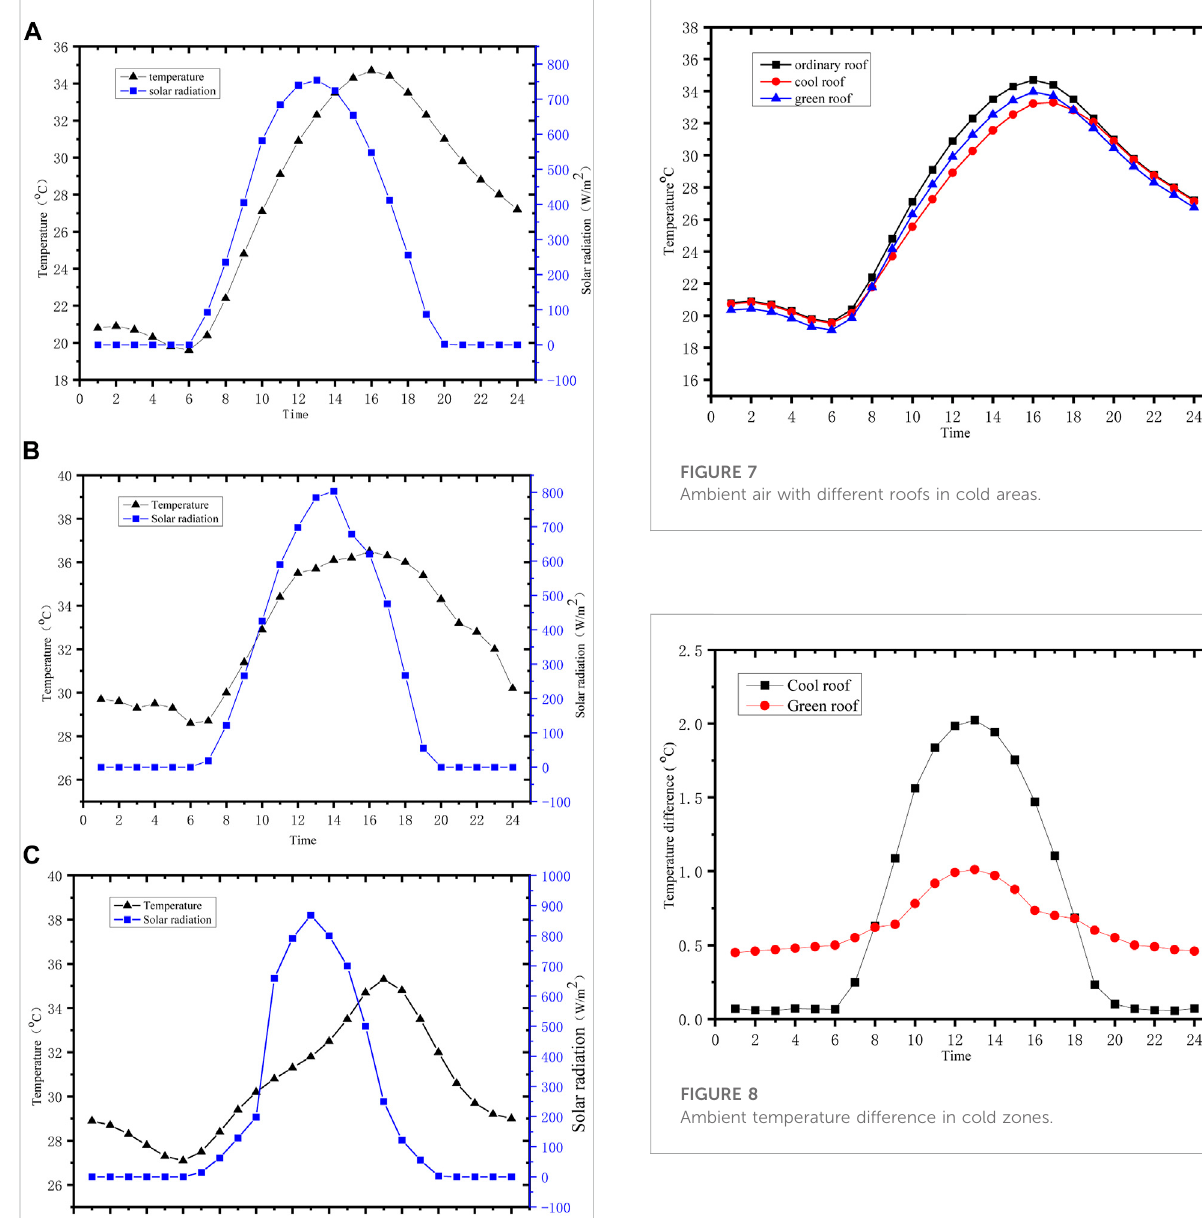
FIGURE 6 (A) Weather parameter of Beijing. (B) Weather parameter of Nanjing. (C) Weather parameter of Guangzhou.